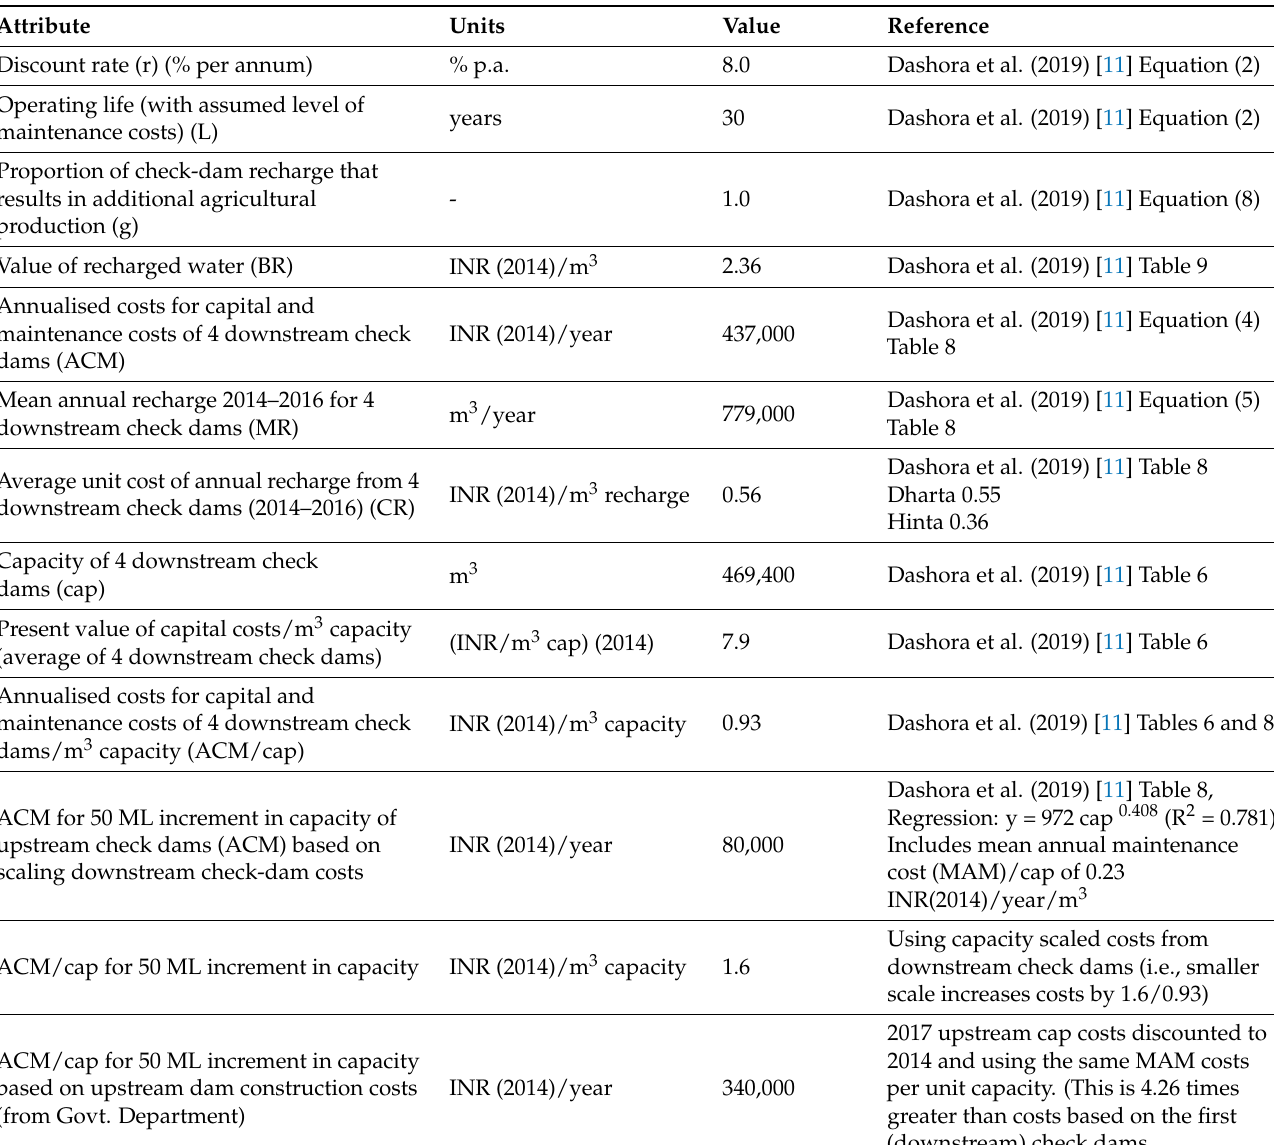
Table 5. Economic valuation of optimum total check-dam capacity based on statistics available for four downstream check dams in this catchment (Dashora et al. 2019) and results of the WaterCress modelling reported